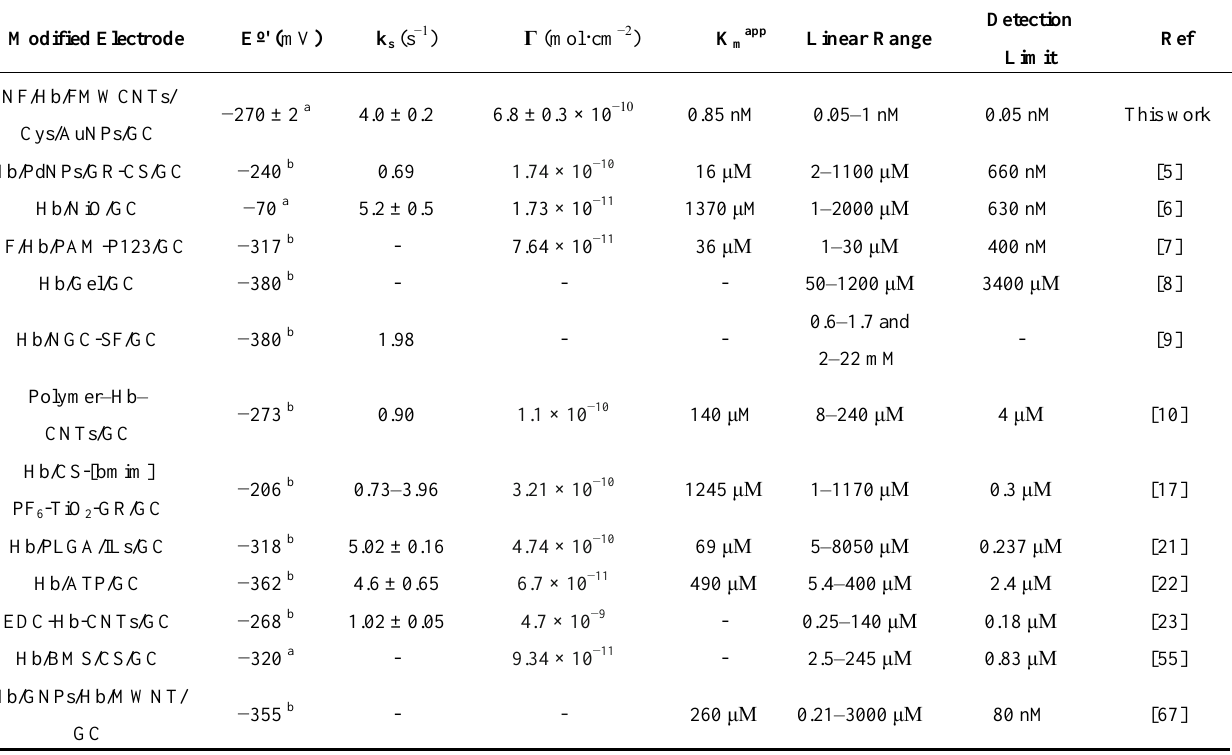
Table 1. Comparison of electrochemical parameters of Hb on different modified GC